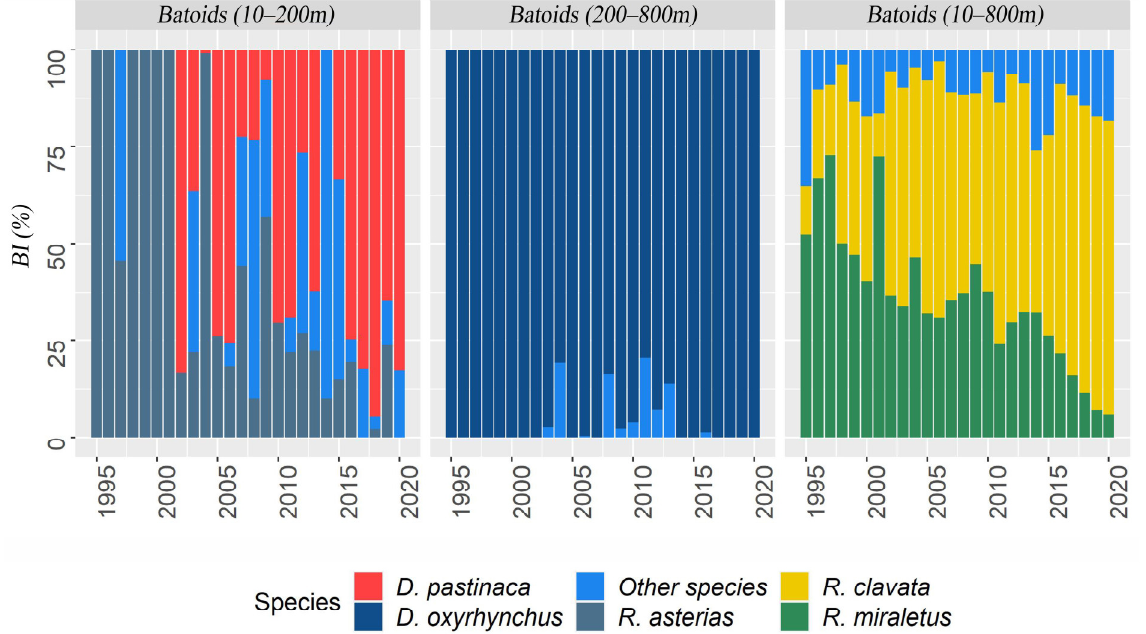
Figure 2. Biomass index (%) of a single skate/ray species among total batoids per depth stratum over the years.